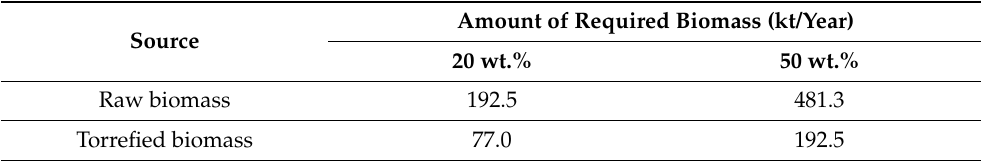
Table 3. Amount of raw biomass and torrefied biomass required to substitute conventional coke in BF on the example of Lorraine, Saint-Gobain PAM plant [90].